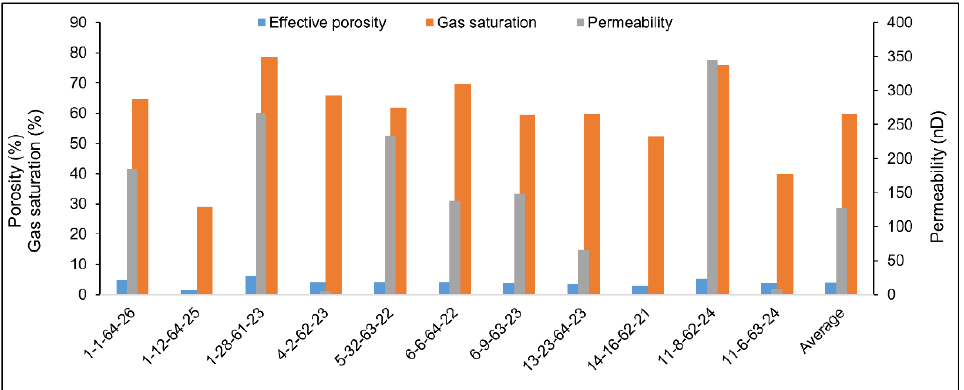
Figure 8. Petrophysical measurements of effective porosity, permeability, and gas saturation for coring wells.